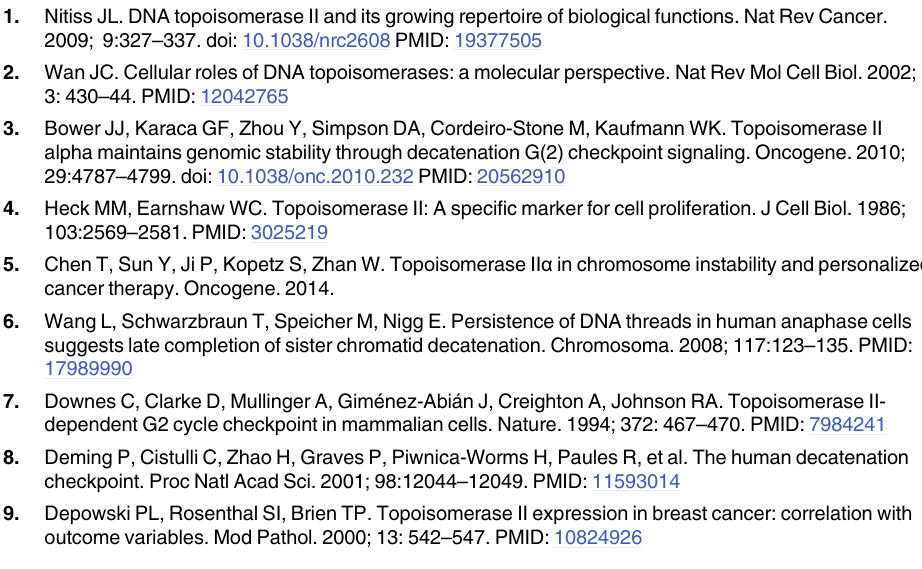
S1 Fig. Generation of prostate cancer cell lines overexpressing TOP2A. (TIF) S2 Fig. Expression of TOP2A and DLX4 in prostate tumor samples. (TIF) S3 Fig. Overexpressed TOP2A remains enzymatically active upon propagation of cells. (TIF) S4 Fig. Genome plots of DNA rearrangements in LNCaP cell line. (TIF) S1 Table. Mate pair sequencing data. (XLSX) S2 Table. Primers used in CHIP